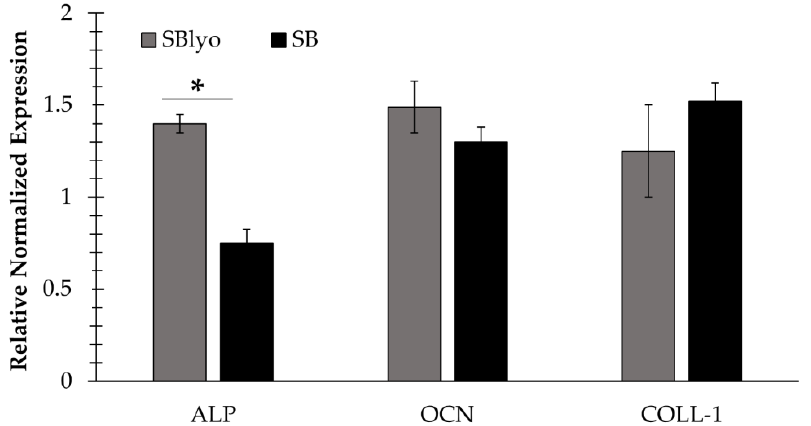
Figure 7. Expression of mature osteoblast markers (ALP, COLL-1, and OCN): marker expression of cells grown on SBlyo (gray) and those grown on untreated SB (black). “*” indicates a significant difference between SB and SBlyo ( p < 0.05).